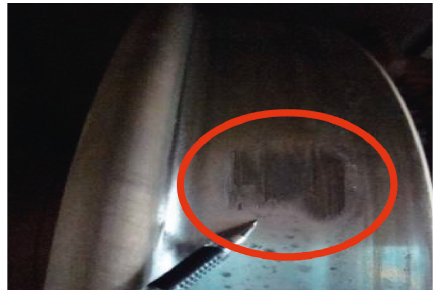
Figure 38: The defect on the tested wheel tread.